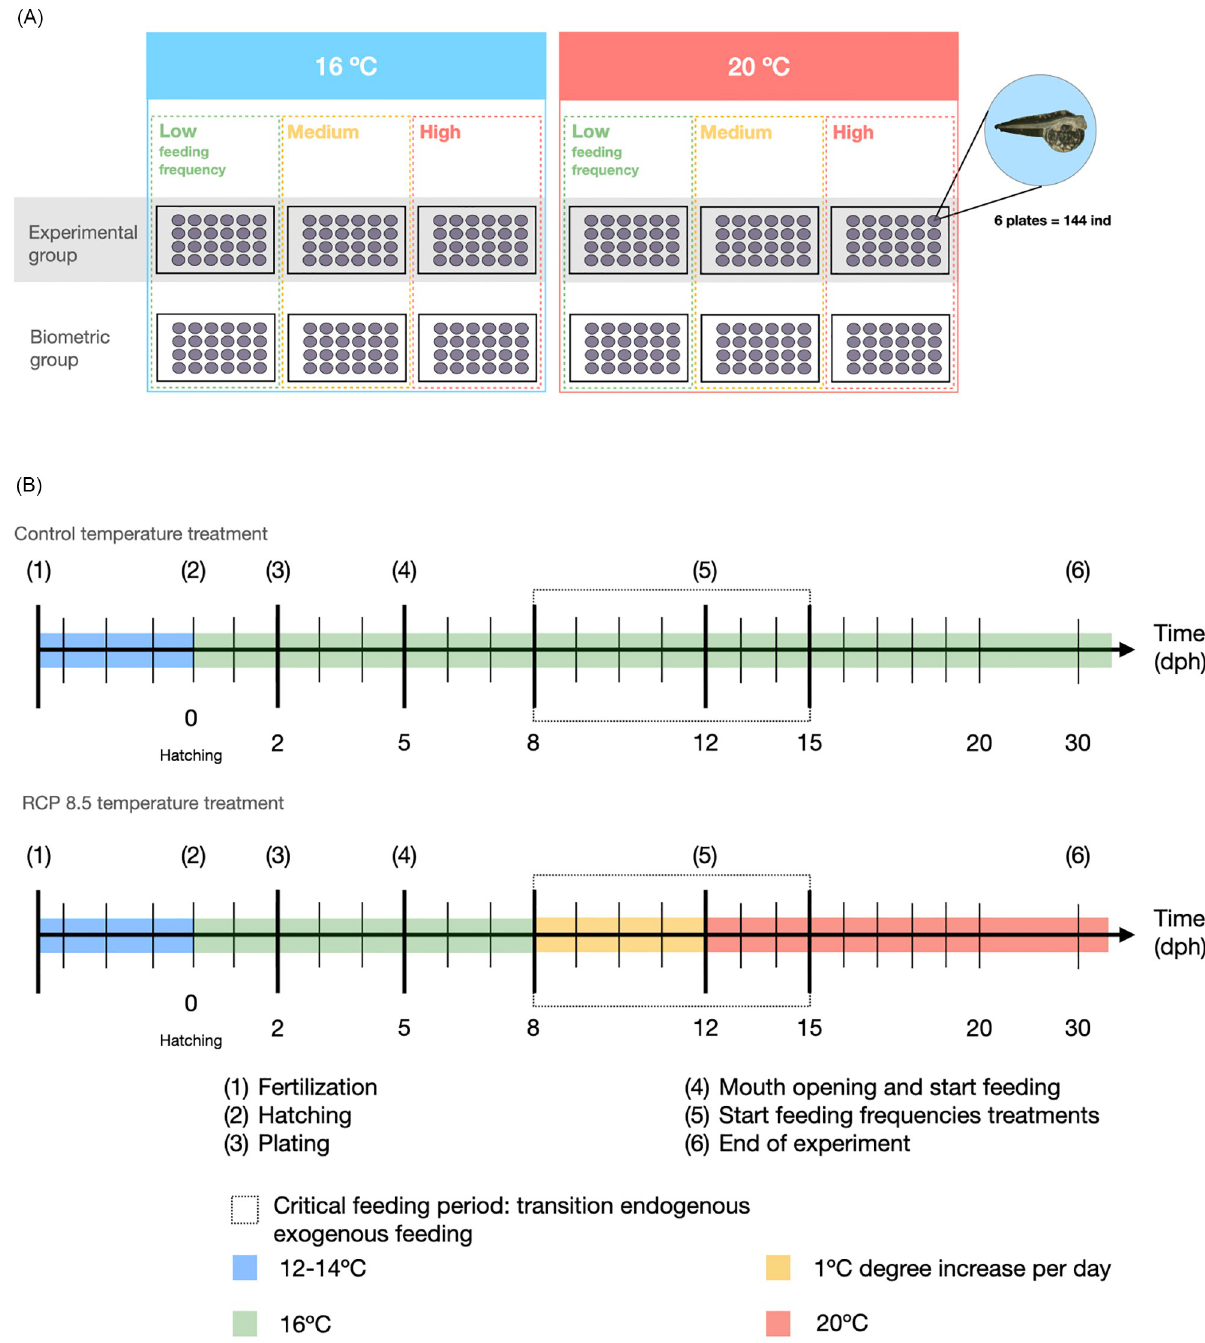
Fig 2. Experimental design. Number of plates used per treatment at both experiment 1 and 2 (a) and timeline protocol followed during experiment 2, for larvae reared at 16˚C (control temperature treatment) and at 20˚C (RCP 8.5 temperature treatment), that included a temperature acclimation for